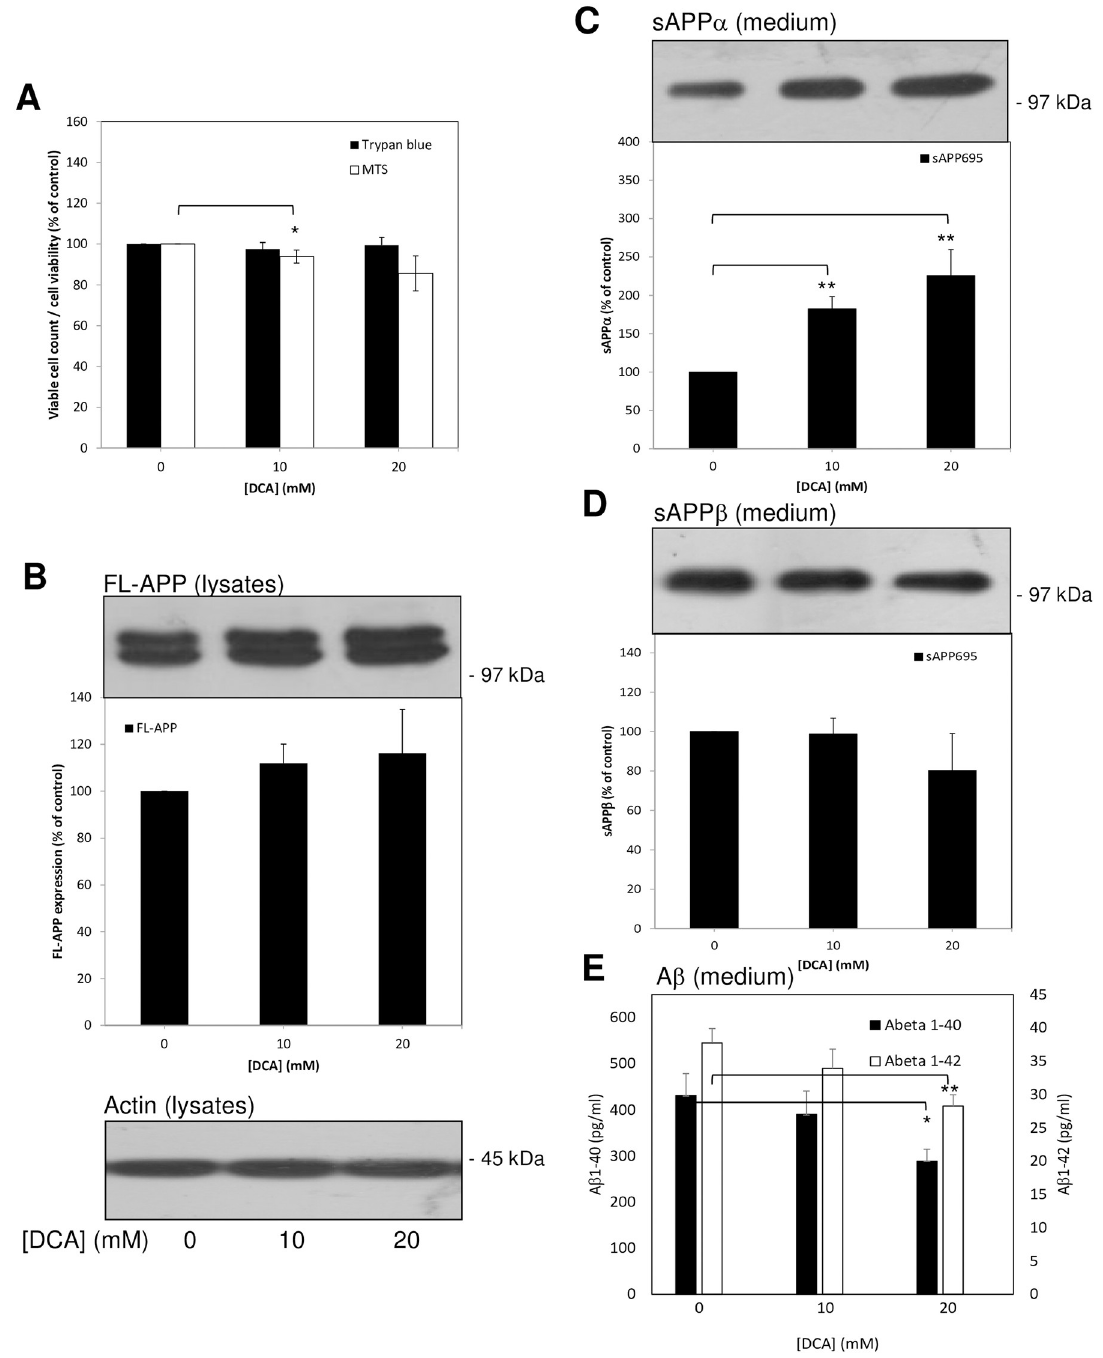
Fig 4. Stable over-expression of APP in SH-SY5Y cells partially ablates the effects of DCA on non-amyloidogenic and amyloidogenic APP processing. Cells were grown to confluence before replacing the growth medium with UltraMEM containing the indicated DCA concentrations and culturing for an additional 24 h. Viability assays were then performed or cell lysate and conditioned medium samples were prepared as described in the Materials and methods section. Equal amounts of protein (lysates) or equal volumes (medium) from samples were subjected to SDS-PAGE and immunoblotting (Materials and methods). (A) Trypan blue and MTS cell viability assays. ( B ) Cell lysates were immunoblotted with anti-APP C-terminal and anti-actin antibodies. Full-length APP (FL-APP) was quantified from multiple immunoblots and the results expressed relative to control values. (C) and (D) Conditioned medium samples were immunoblotted with anti-APP 6E10 antibody in order to detect sAPP α (C) or anti-sAPP β antibody (D) . Multiple immunoblots were then quantified and results expressed relative to control values. (E) A β -peptide quantification in conditioned medium; results are